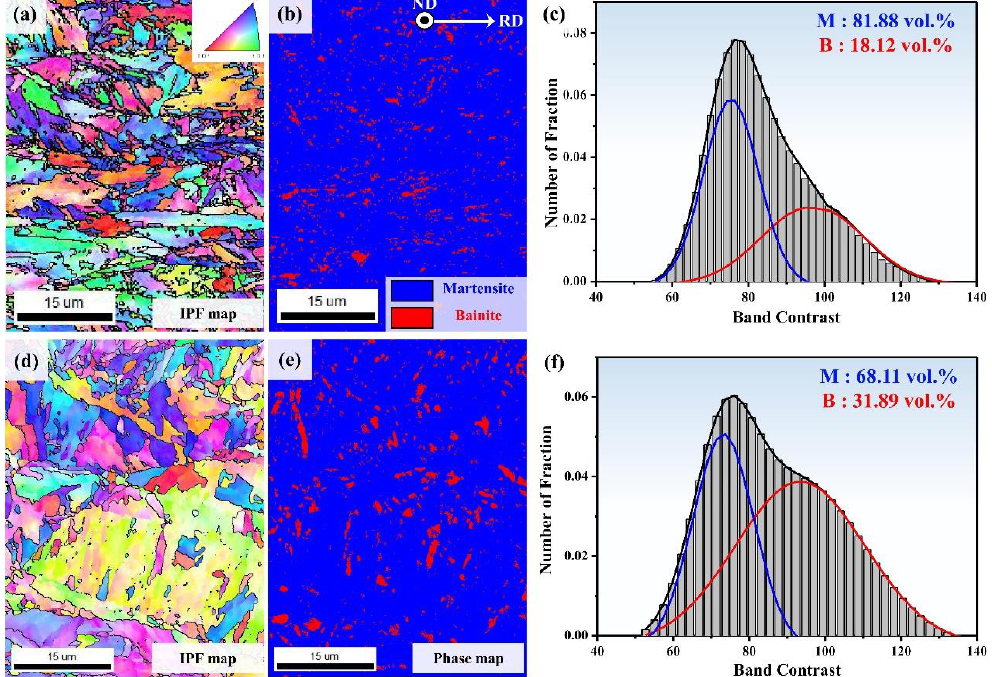
Figure 5. ( a ) IPF map of center region of direct-quenched steel (alloy A) ( b ) with corresponding selected area phase map and ( c ) Gaussian graphs in ( a ) revealing prominent martensite (blue) & bainite (red); ( d ) IPF map of alloy B ( e ) with phase map and ( f ) Gaussian graphs in ( c ).